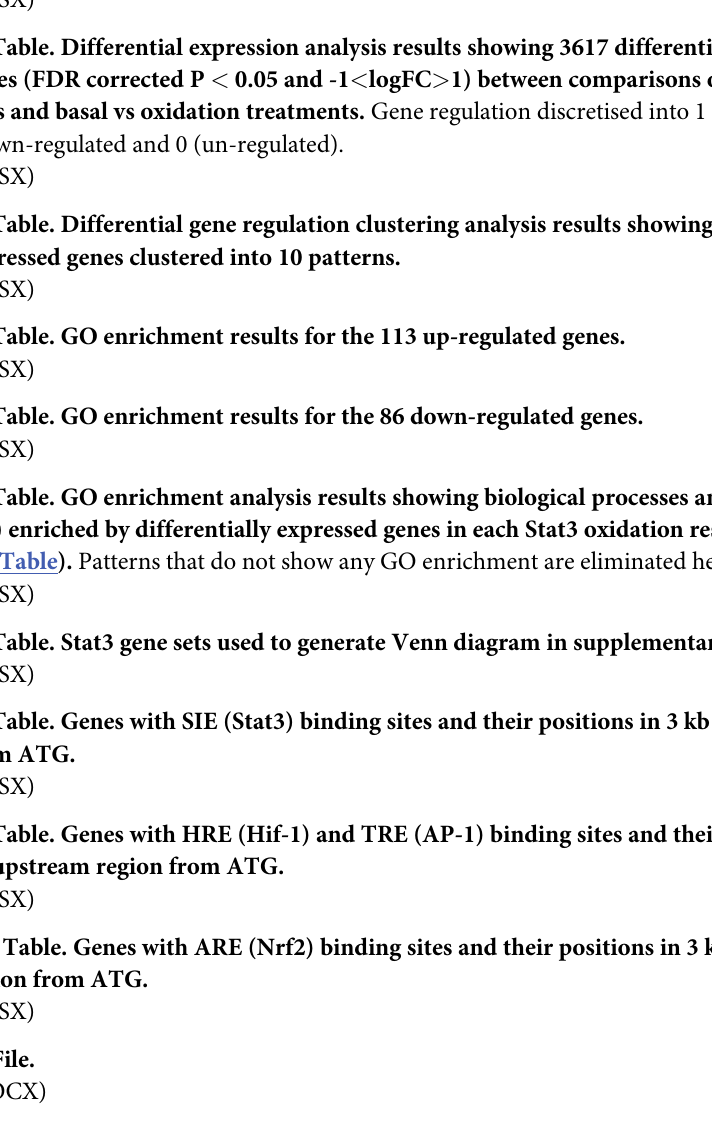
S1 Table. Mapping of high quality reads generated using Illumina Hiseq 2500 sequencing platform to mm10 reference genome using Tophat2 v2.0.10. S2 Table. Differential expression analysis results showing 3617 differentially expressed genes (FDR corrected P < 0.05 and -1 < logFC > 1) between comparisons of -/-WT vs -/-C3S cells and basal vs oxidation treatments. Gene regulation discretised into 1 (up regulated), -1 (down-regulated and 0 (un-regulated). S3 Table. Differential gene regulation clustering analysis results showing 199 differentially expressed genes clustered into 10 patterns. S4 Table. GO enrichment results for the 113 up-regulated genes. S5 Table. GO enrichment results for the 86 down-regulated genes. S6 Table. GO enrichment analysis results showing biological processes and their log(p-val- ues) enriched by differentially expressed genes in each Stat3 oxidation responsive pattern (S3 Table). Patterns that do not show any GO enrichment are eliminated here. S7 Table. Stat3 gene sets used to generate Venn diagram in supplementary S4E Fig. S8 Table. Genes with SIE (Stat3) binding sites and their positions in 3 kb upstream region from ATG. S9 Table. Genes with HRE (Hif-1) and TRE (AP-1) binding sites and their positions in 3 kb upstream region from ATG. S10 Table. Genes with ARE (Nrf2) binding sites and their positions in 3 kb upstream region from